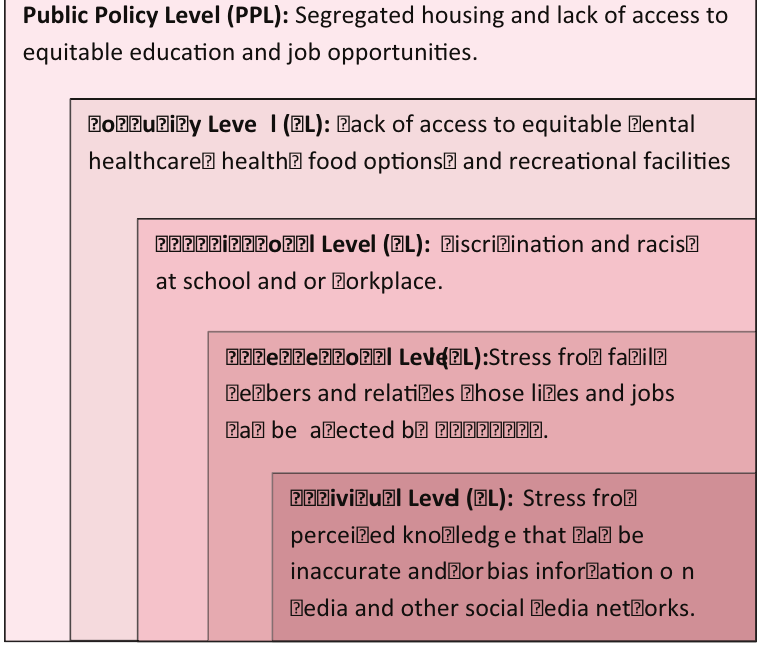
Figure 1: Social ecological model delineating social determinants of mental health aggravated by systemic racism among African American families in the era of COVID-19